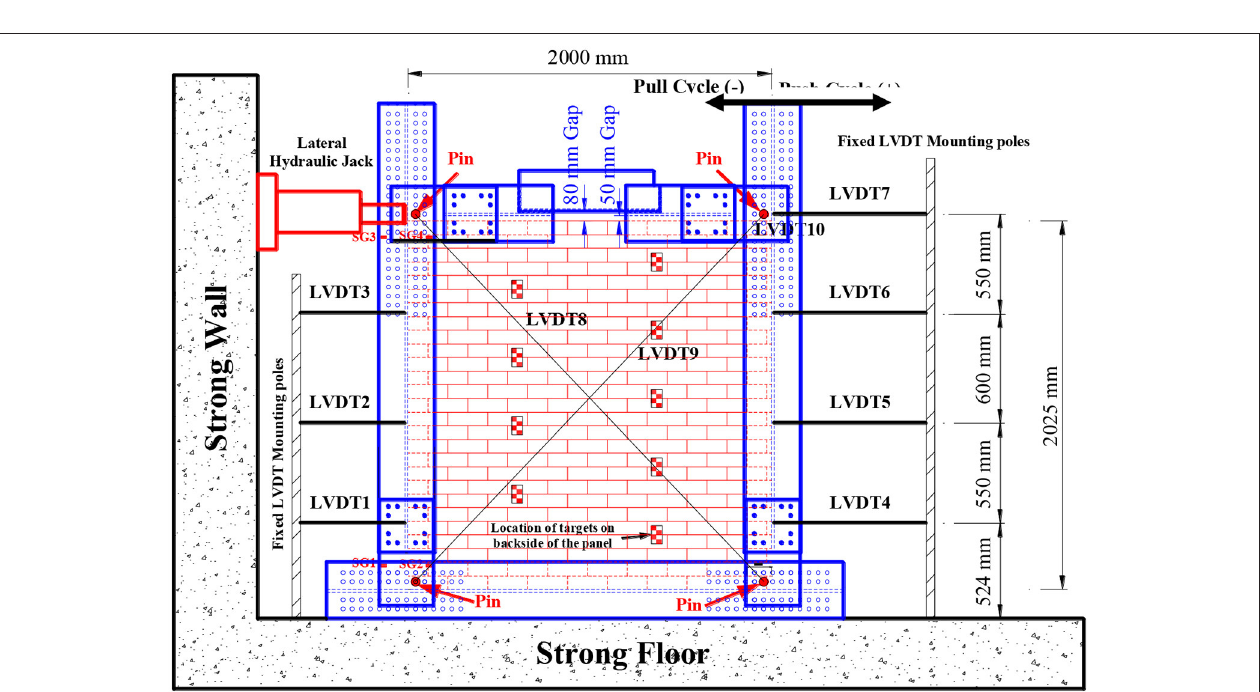
FIGURE 13 | Experimental setup for in-plane cyclic test of semi-interlocking masonry (SIM) panels. cracking has been monitored through visual inspection, with the acquisition always